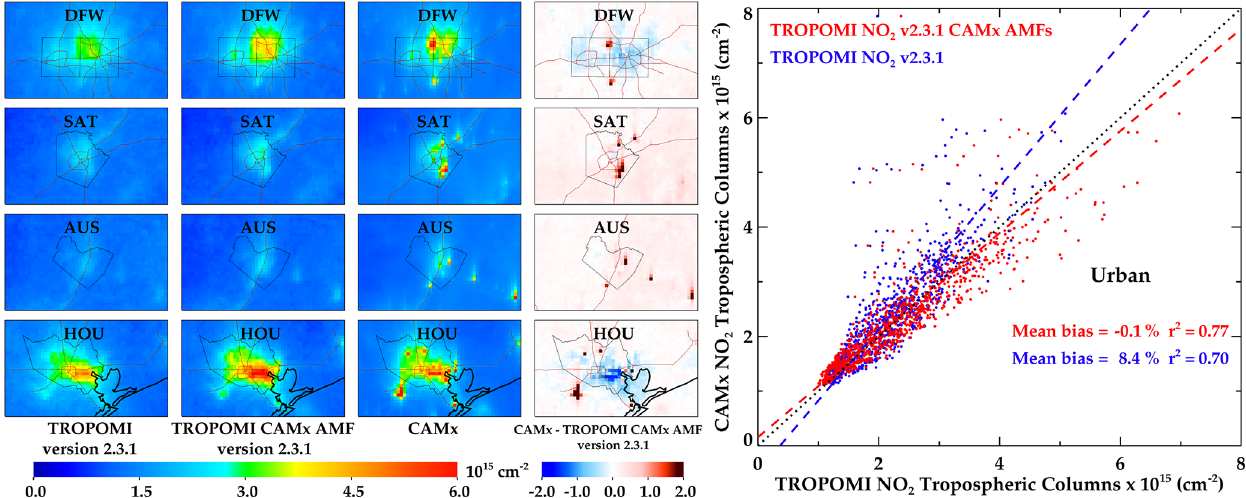
Figure 6. The NO 2 tropospheric vertical column amounts averaged across April through September 2019 from TROPOMI, TROPOMI v2.3.1, and TROPOMI v2.3.1 with new AMF and CAMx for the largest four metropolitan areas (Dallas–Fort Worth, San Antonio, Austin, and Houston). The right panel is a scatterplot showing the slope and correlation of various TROPOMI configurations and CAMx.